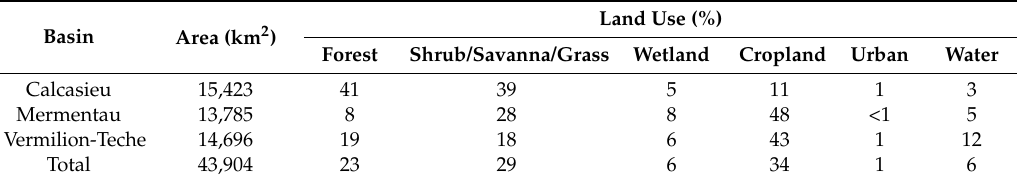
Table 1. Land use information for the three